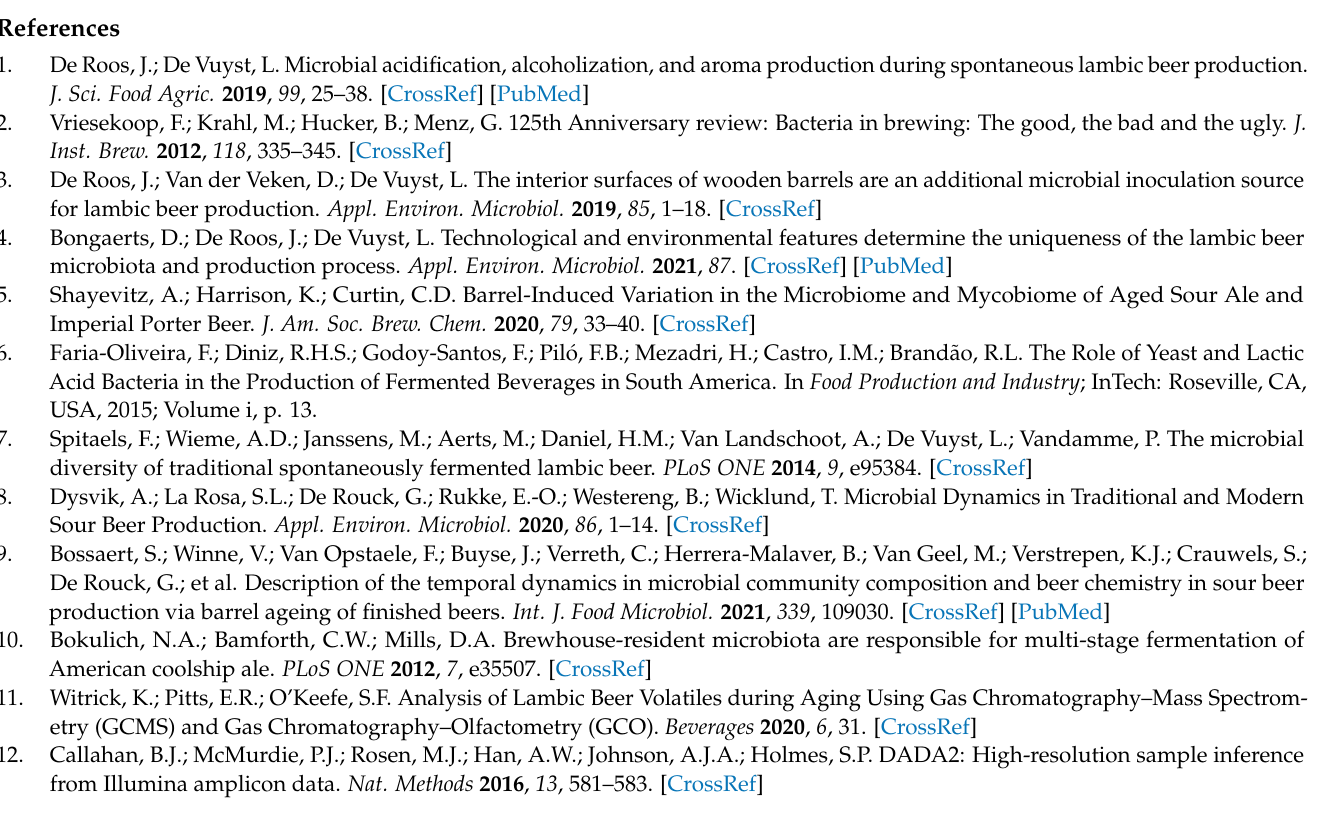
Figure A1. Enterobacteriaceae family presence in the bacterial composition of the analyzed samples. Bacteria from the Enterobacteriaceae family are commonly detected in the first fermentation phase of mixed-fermentation beers produced by spontaneous fermentation (De Roos and De Vuyst, 2019) and in our study they could be identified in relevant proportions in samples 1, 6, 7, 14, 19, and 20 (>8% of the ASVs detected in each